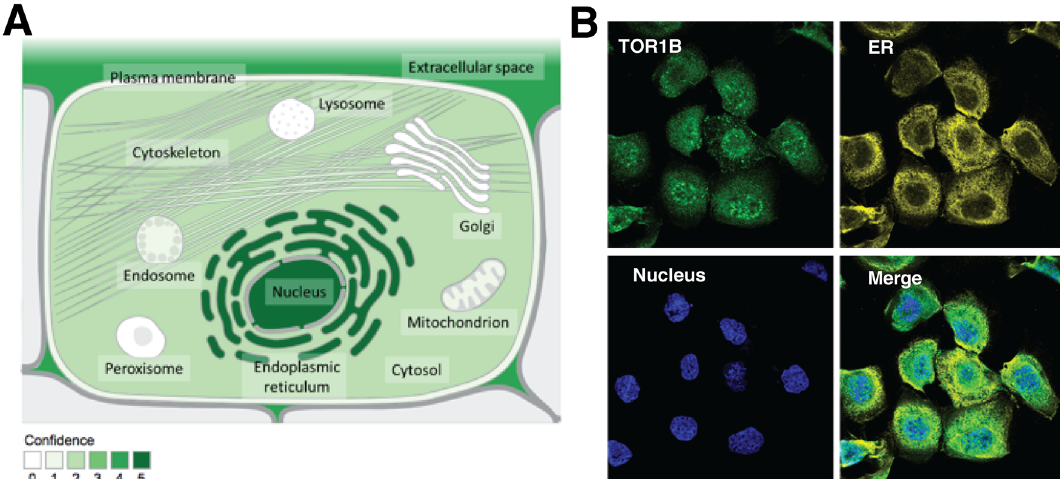
Figure 1. The localization of TOR1B at the cellular level. Subcellular locations from COMPARTMENTS ( A ) and the Protein Atlas ( B ). The confidence of each association is signified by stars, where ★★★★★ is the highest confidence and ★☆☆☆☆ is the lowest. All Image data shown were generated and downloaded with searching the queries from COMPARTMENTS (compartments.jensenlab.org) or Human Protein Atlas (www. prote inatl as. org, Protein Atlas version